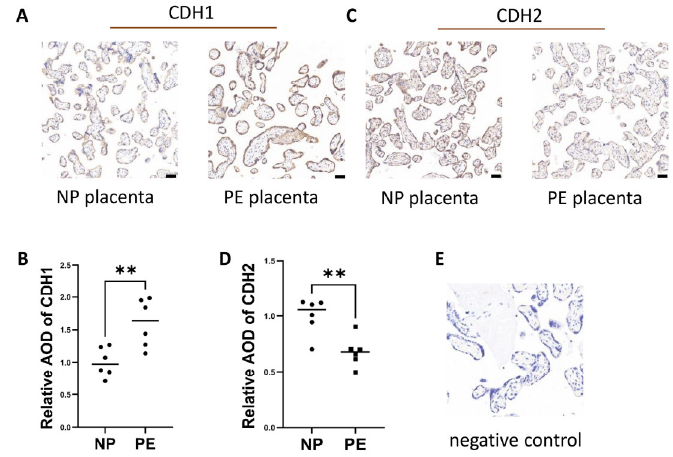
Figure 2. Excess epithelial pattern in trophoblasts in PE patients. ( A , B ) CDH1 protein expression in placental tissues from women with NP and PE was measured by immunohistochemical staining. ( C , D ) CDH2 protein expression in placental tissues from women with NP and PE was measured by immunohistochemical staining. ( E ) represents negative control. Values are the mean ± SD. ** p < 0.01; ns, not significant. n = 6 each. Scale bar = 50 nm.